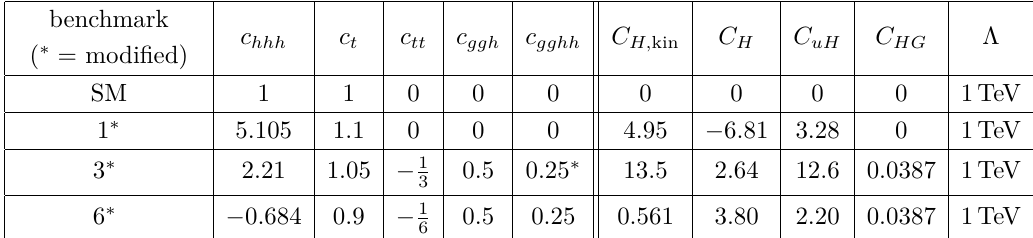
Table 2 . Benchmark points used for the total cross sections and the distributions of the invariant mass of the Higgs-boson pair, cf. table 3 and figures 2–4. The value of C α s ( m Z ) = 0 . 118